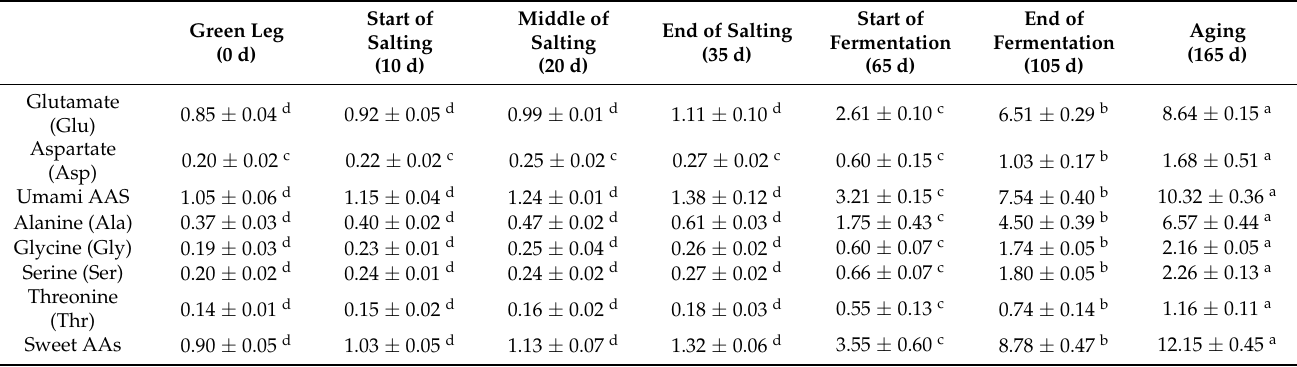
Table 2. Changes of free amino acids in samples during the processing of dry-cured donkey leg